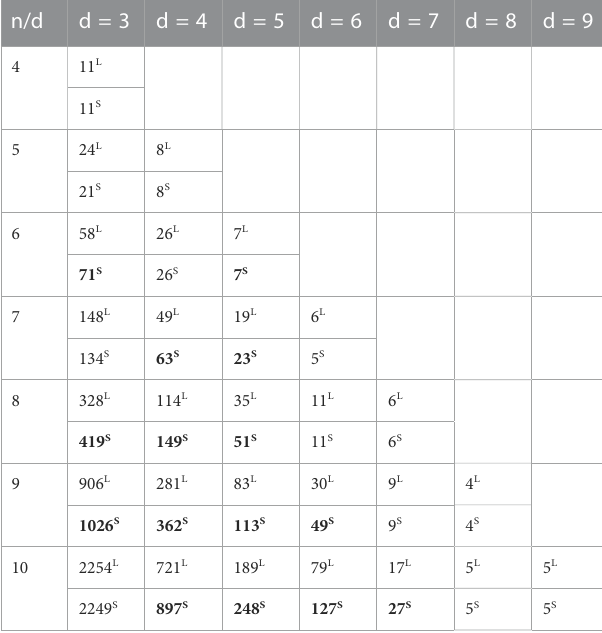
TABLE 4 Lower bounds of MFOS with C GC,NL,RC ( n,W,d ) .